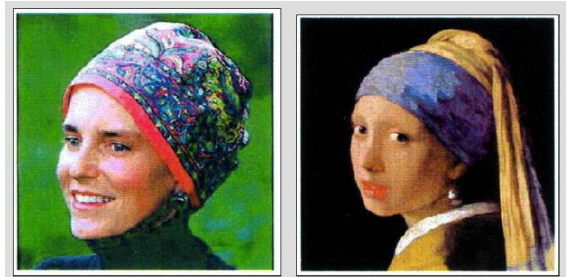
Figures 1a: Example of a snapshot/ picture (Vermeer)